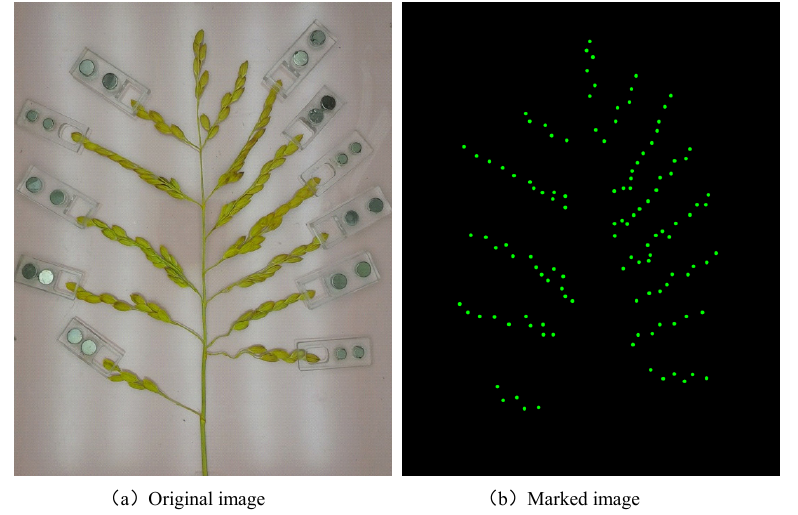
Figure 3. The human–computer interaction interface of the dot mark. Figure 4. Image labeling.